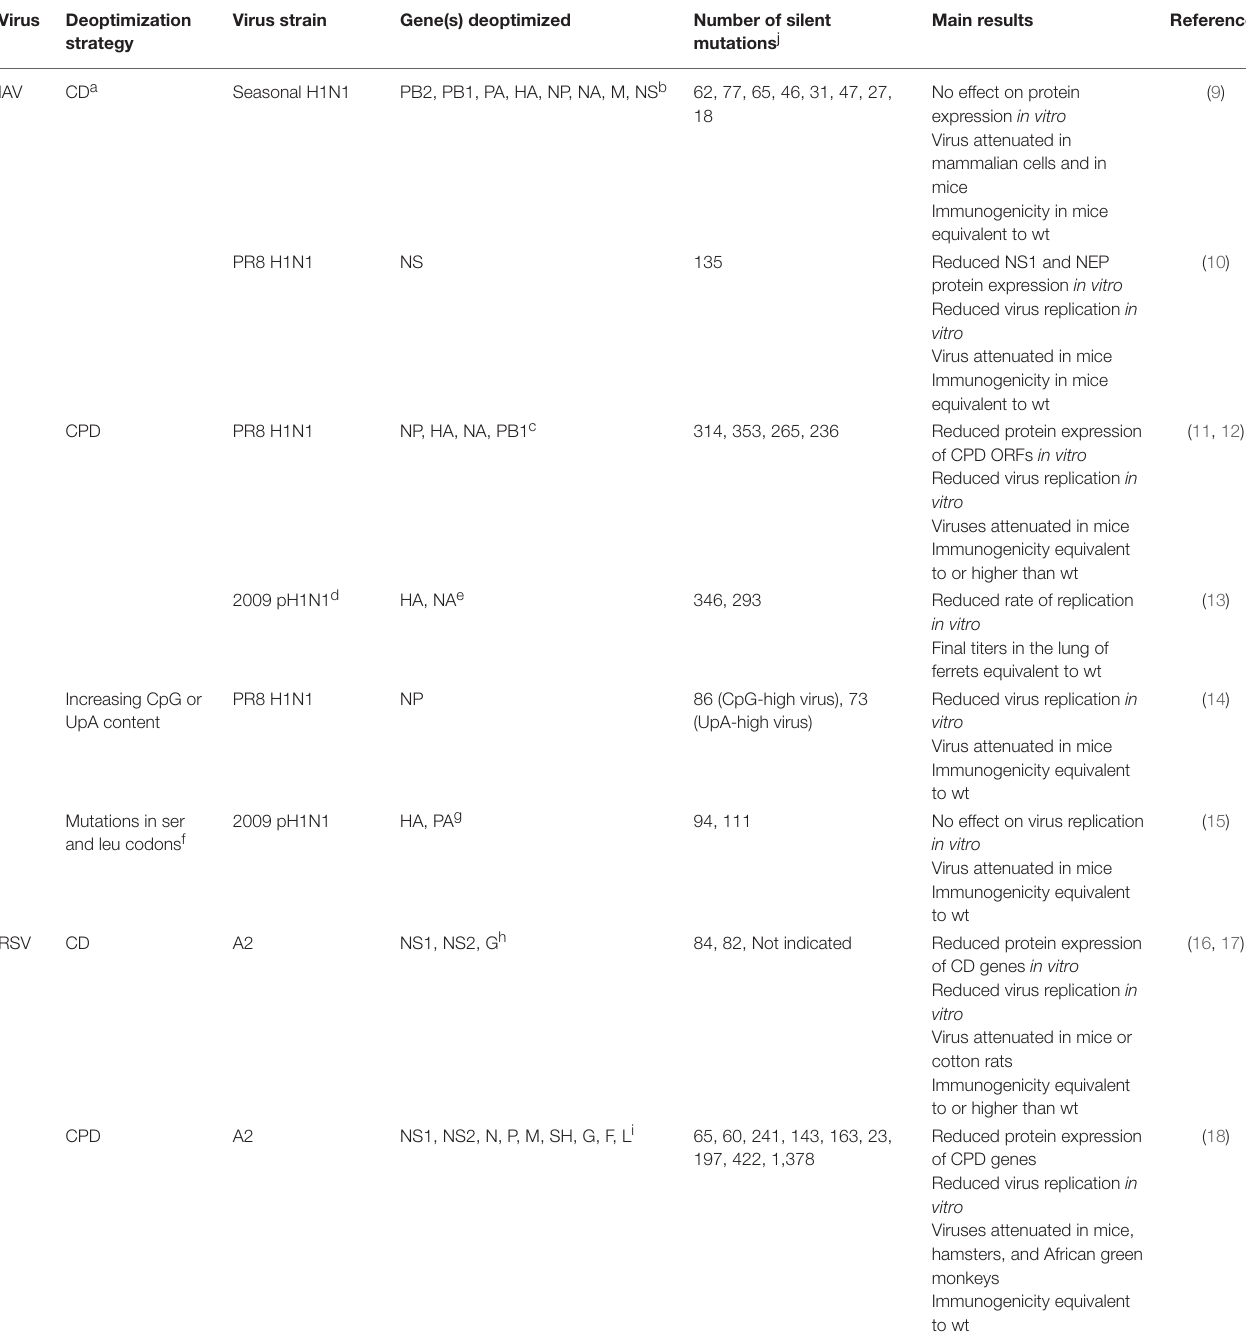
TABLE 1 | Attenuation of influenza and respiratory syncytial virus by synonymous genome recoding.